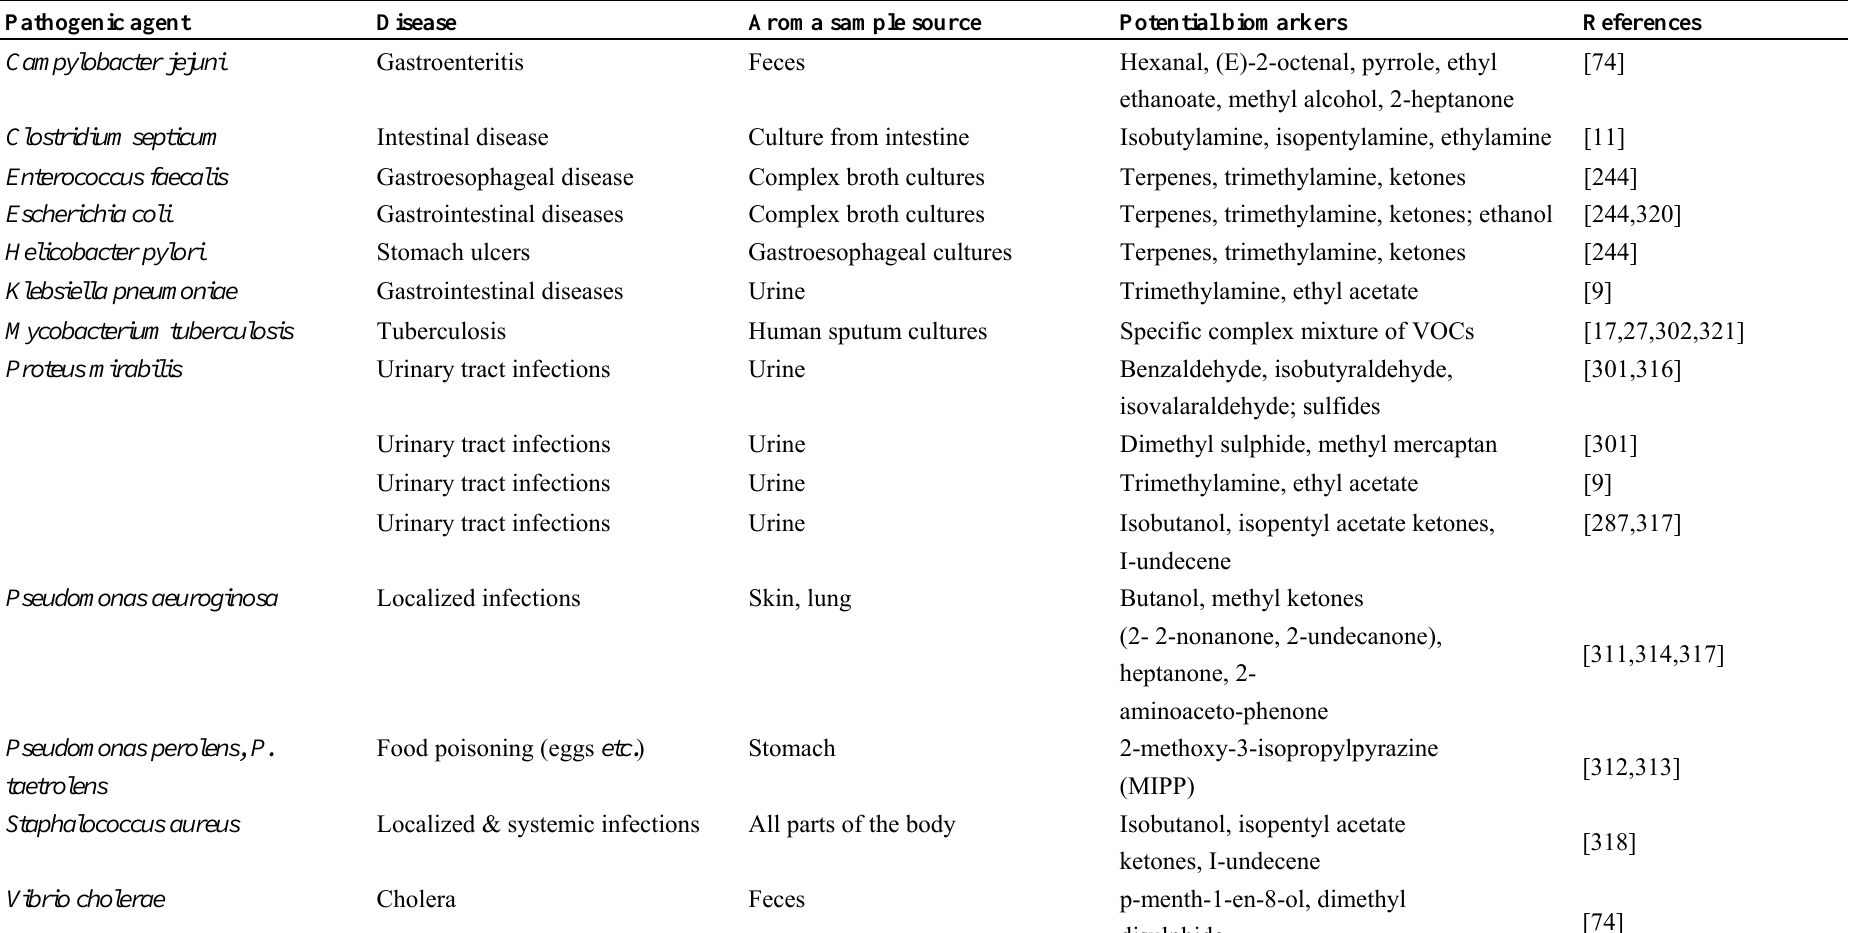
Table 4. Potential electronic-nose applications for human and animal disease diagnoses via detection of volatile biomarker indicator compounds produced by bacterial pathogens that are causal agents of specific